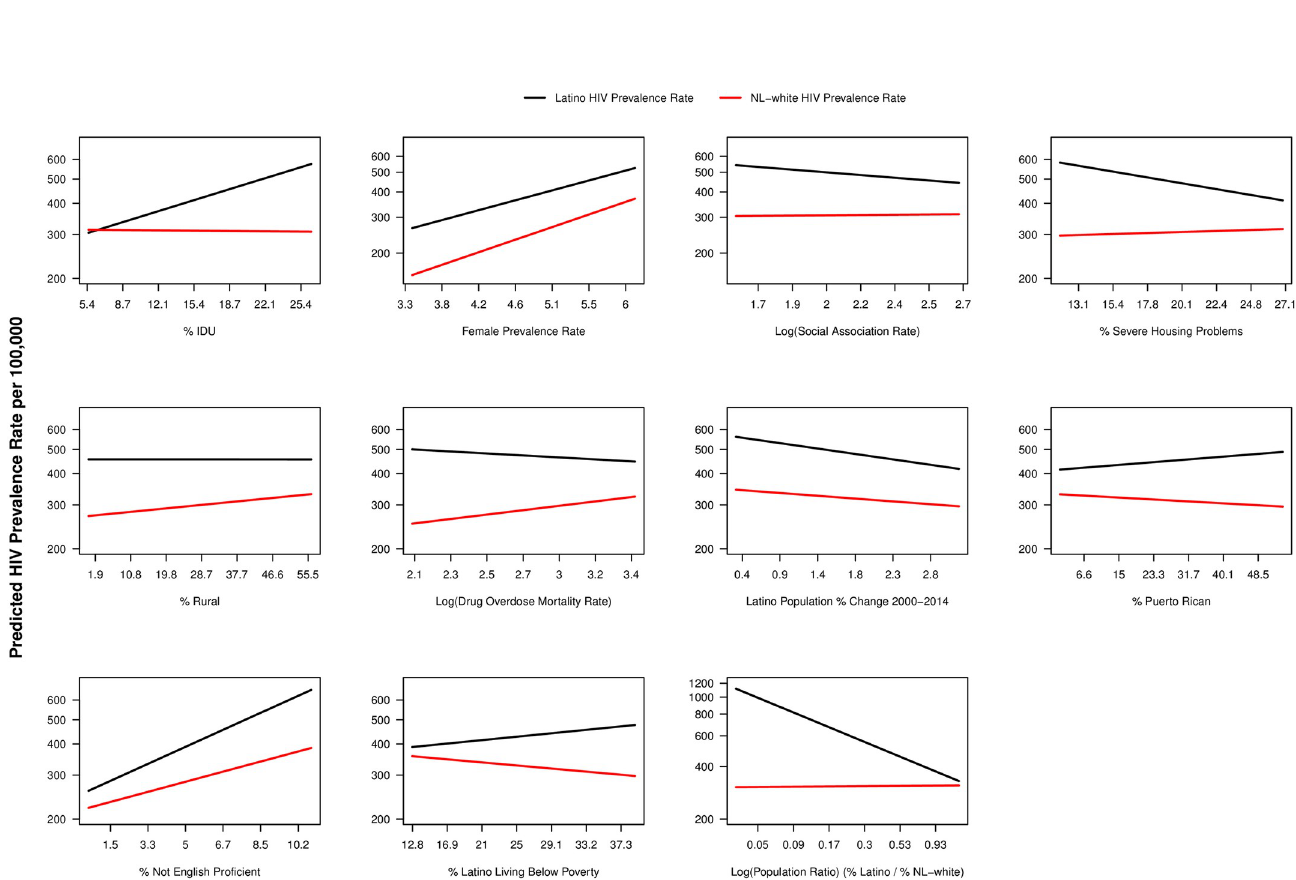
Fig 4. Moderator effects on the estimated HIV prevalence rate for significant factors in multivariate